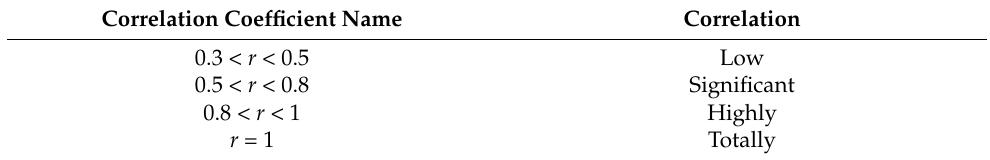
Table 1. Relevance judgment principles.